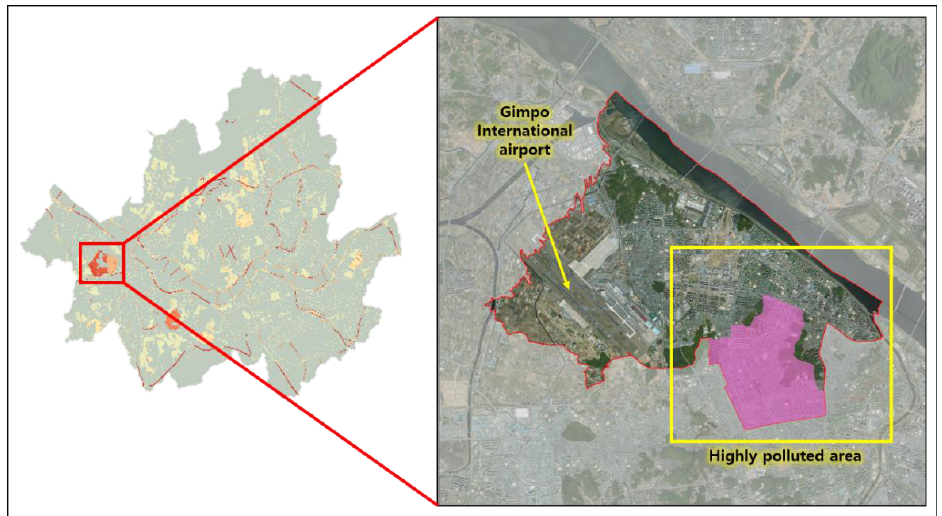
Figure 3. Satellite image of a highly polluted area (Gangseo-gu district).